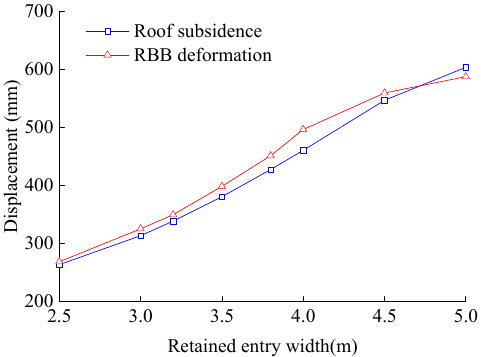
Figure 8. Relationship between the retained entry width and roof subsidence, RBB deformation.